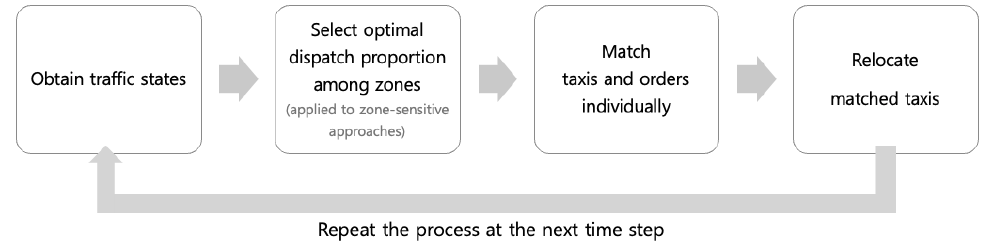
Figure 1. Taxi dispatch decision